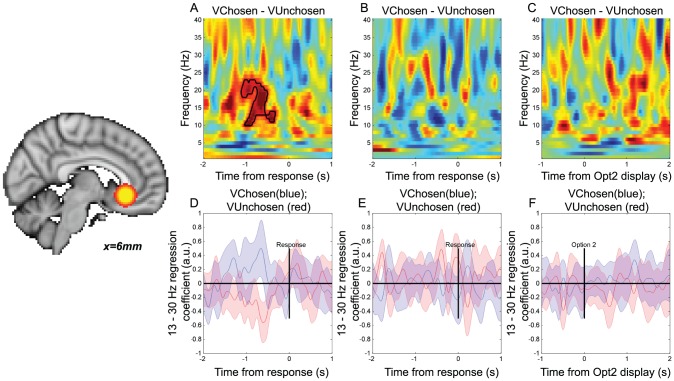
Ventromedial prefrontal cortex (VMPFC) beta band synchronisation reflects value difference on harder ‘comparison’ trials, but not on ‘sequential’ trials.(A) Correlates of the value difference between chosen and unchosen options, timelocked to the response, on harder comparison trials. Color represents T-statistic; bordered areas reflect significant clusters (cluster-corrected P<0.05; permutation test). (B) As (A), but for ‘nobrainer’ trials in which probability and magnitude advocated the same response. (C) Correlates of the value difference between chosen and unchosen options, timelocked to option 2 presentation, on harder sequential trials. (D) Separating the VMPFC beta band response on harder comparison trials reveals a positive correlate of the value of the chosen option (blue) and a negative correlate of the value of the unchosen option (red) prior to the response. Bars represent mean +/− 95% confidence intervals across subjects. (E) As (D), but for ‘nobrainer’ trials. (F) Separating the beta band response on harder sequential trials reveals no correlate of either chosen or unchosen value in VMPFC at the time of option 2 presentation.